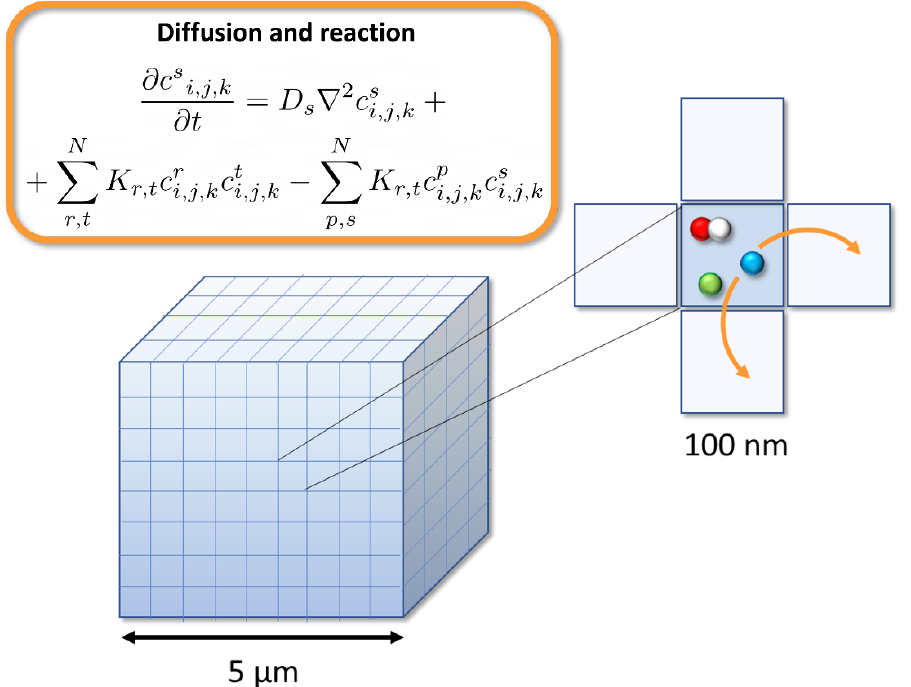
Figure 8. 3D lattice employed in the simulations and diffusion and reaction scheme between adjacent cells.